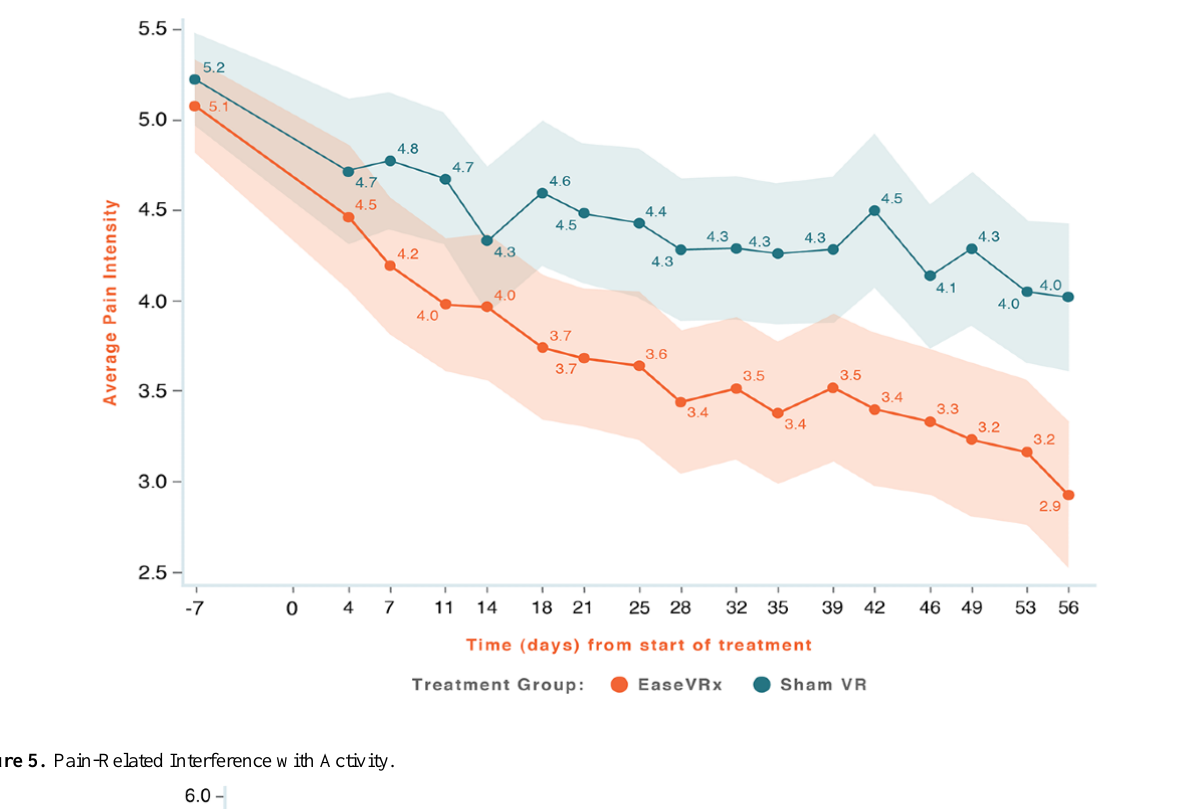
Figure 4. Average pain intensity.